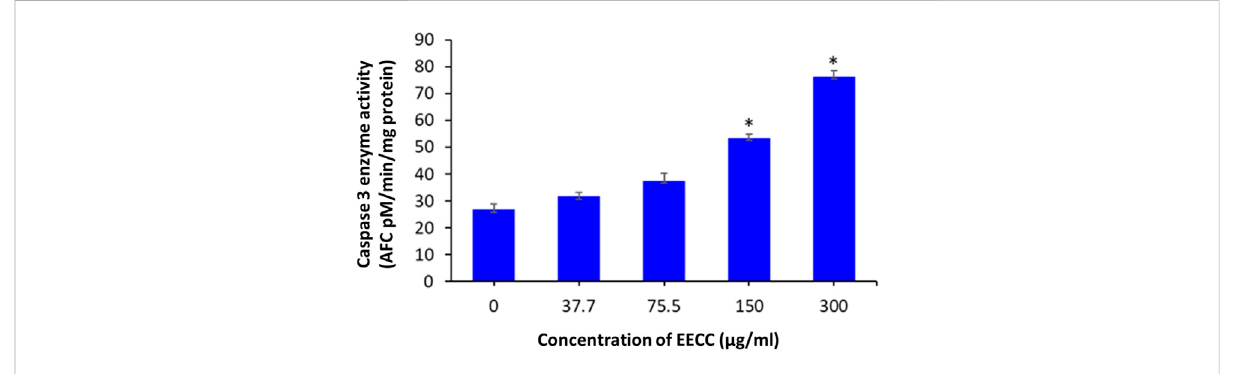
FIGURE 6 Caspase-3 enzyme activity in MCF- cells following exposure to different concentrations of ethanol extracts of Calligonum comosum for 48 h * p < 0.05 vs. control. Data represent mean ± SD of eight technical